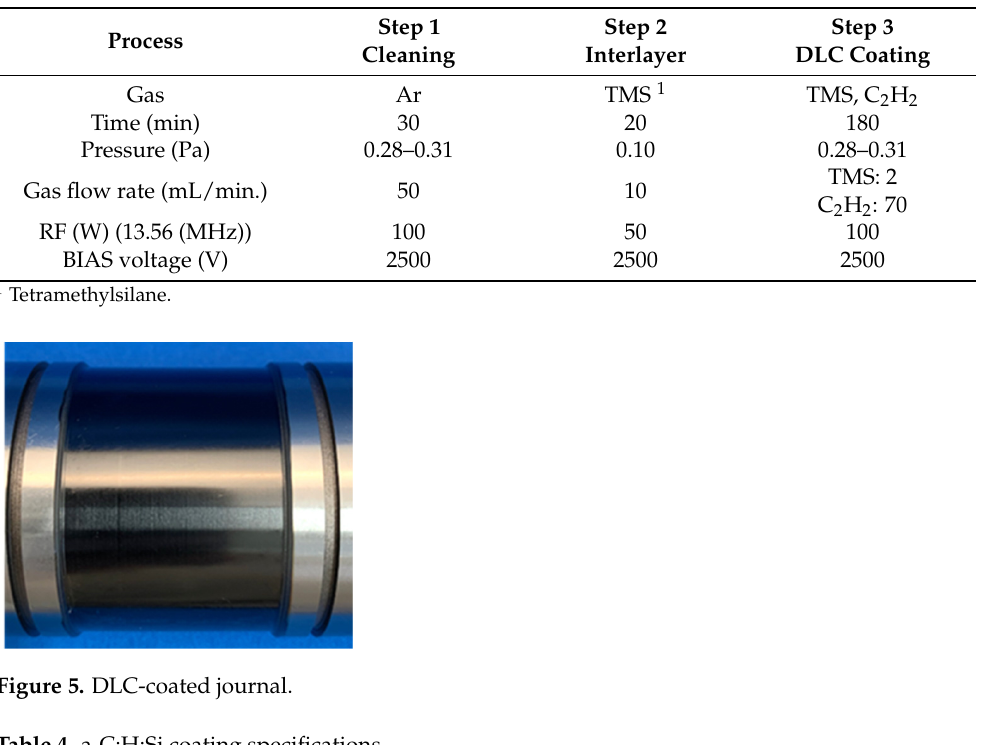
Table 3. PECVD deposition process of a-C:H:Si coating to journal.